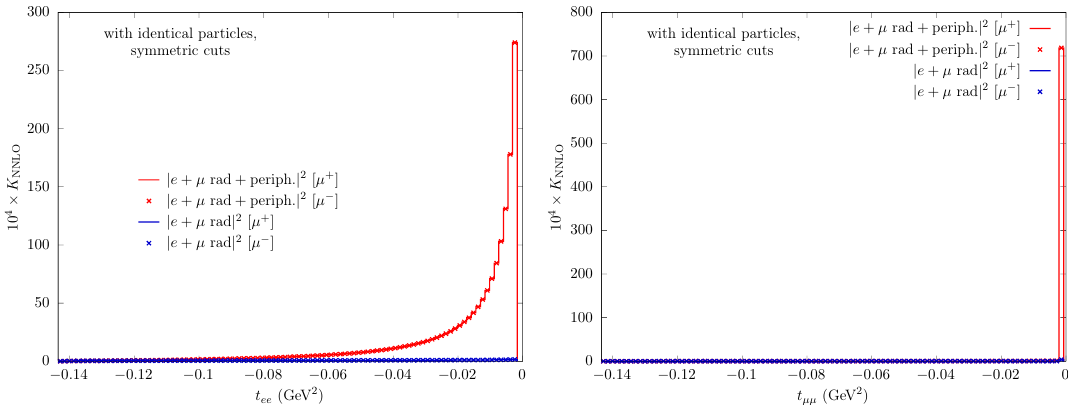
Figure 20. Left: t ee differential K NNLO factor for real e + e − radiation with realistic event selection, without acoplanarity cut. Right: the same for t